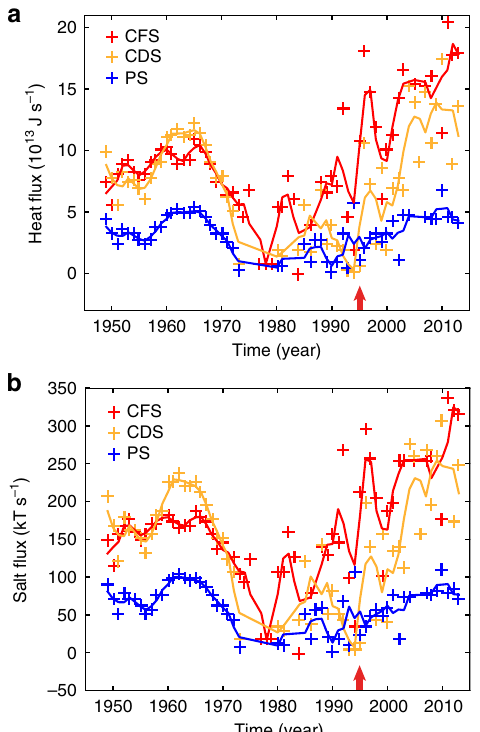
Figure 3 | Heat and salt fluxes of Irminger Water for the period 1949–2013. ( a ) Heat and ( b ) salt fluxes of Irminger Water are measured at three sections in southwest Greenland. Locations of three sections are shown in Fig. 1. CDS, Cape Desolation Section; CFS, Cape Farewell Section; PS, Paamiut Section. Solid line represents a 3-year running average, yearly data shown by plus signs. Red arrow marks the onset time of accelerated mass loss for Greenland estimated from GRACE (Fig.